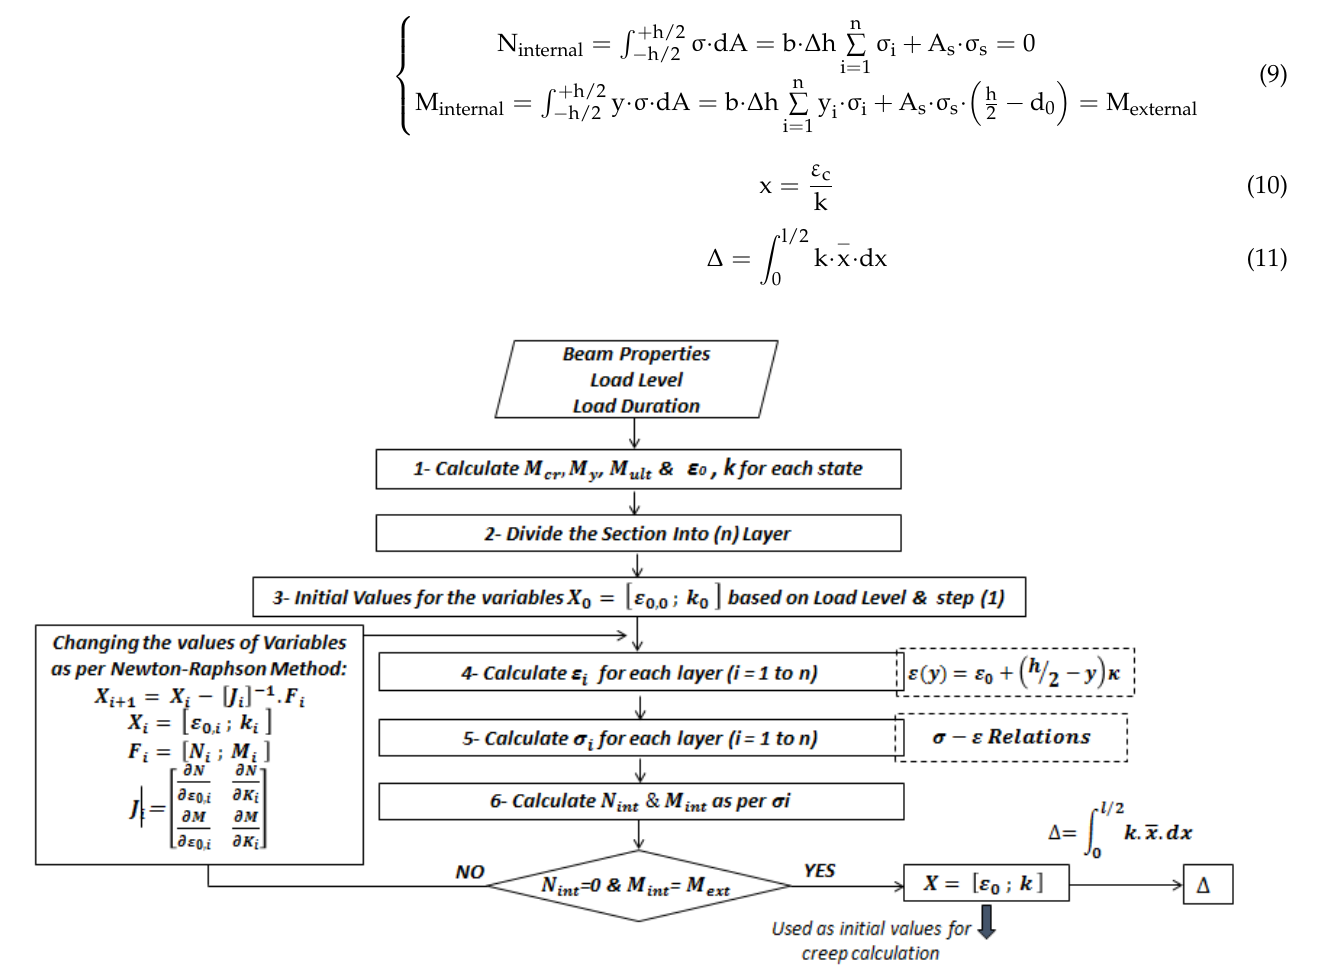
Figure 5. Work flow algorithm for initial loading.